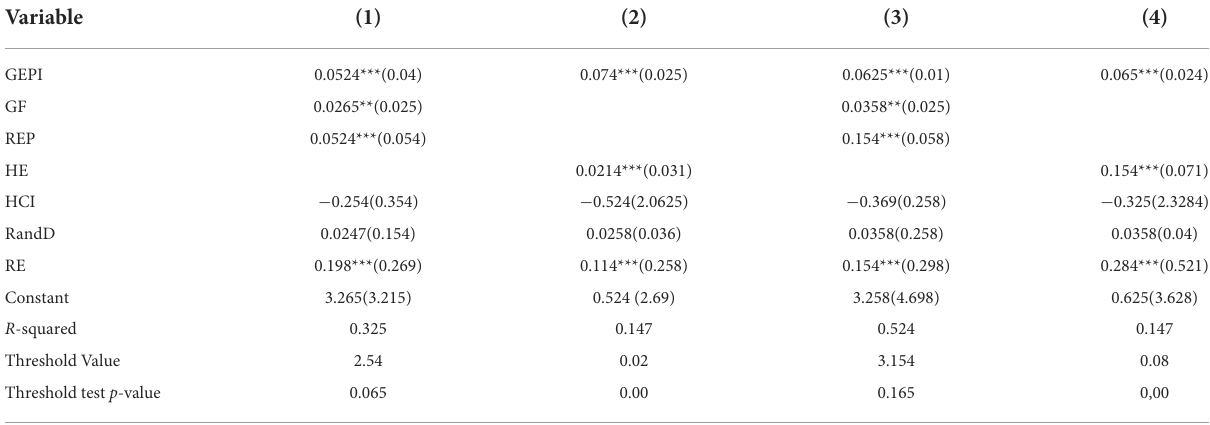
TABLE 8 Threshold regression results.